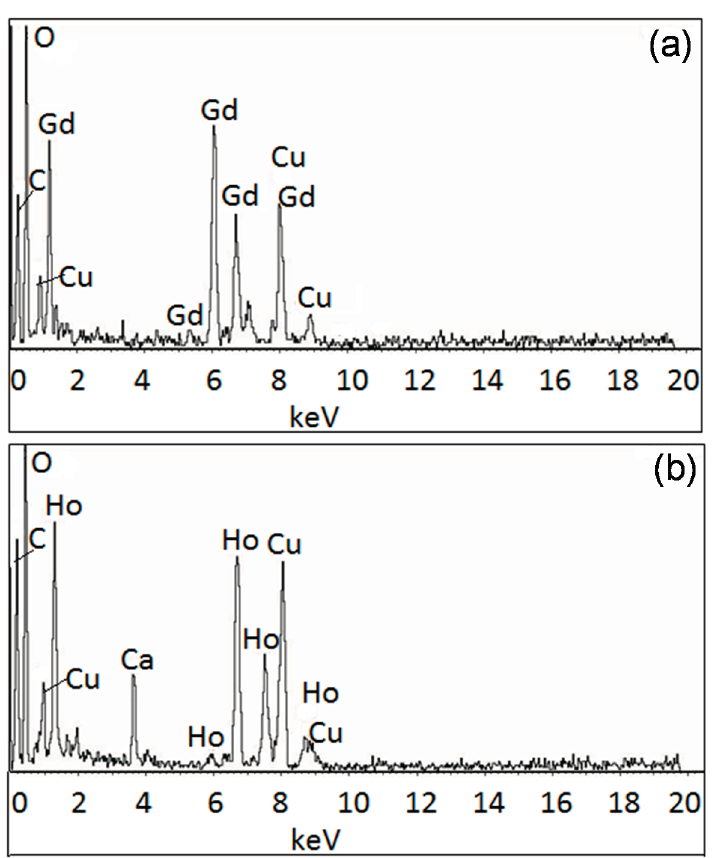
Figure 5. TEM/EDX analysis of the chemically-synthesized ( a ) Fe–Gd–O and ( b ) Fe–Ho–O magnetic nanoparticles.